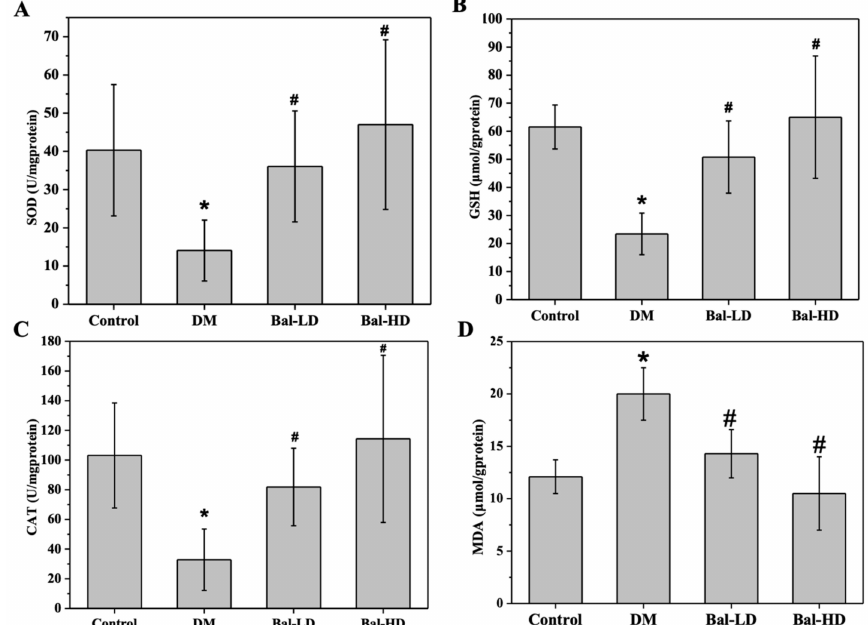
Figure 3. The e ff ect of baicalein on the biomarkers of oxidative stress in the liver tissues of mice with type 2 diabetes mellitus (T2DM). The levels of SOD ( A ), CAT ( B ), GSH ( C ), and MDA ( D ) were determined by the corresponding assay kit. The data were presented as the mean ± SD ( n = 3). * p < 0.05 vs. control group; # p < 0.05 vs. HG